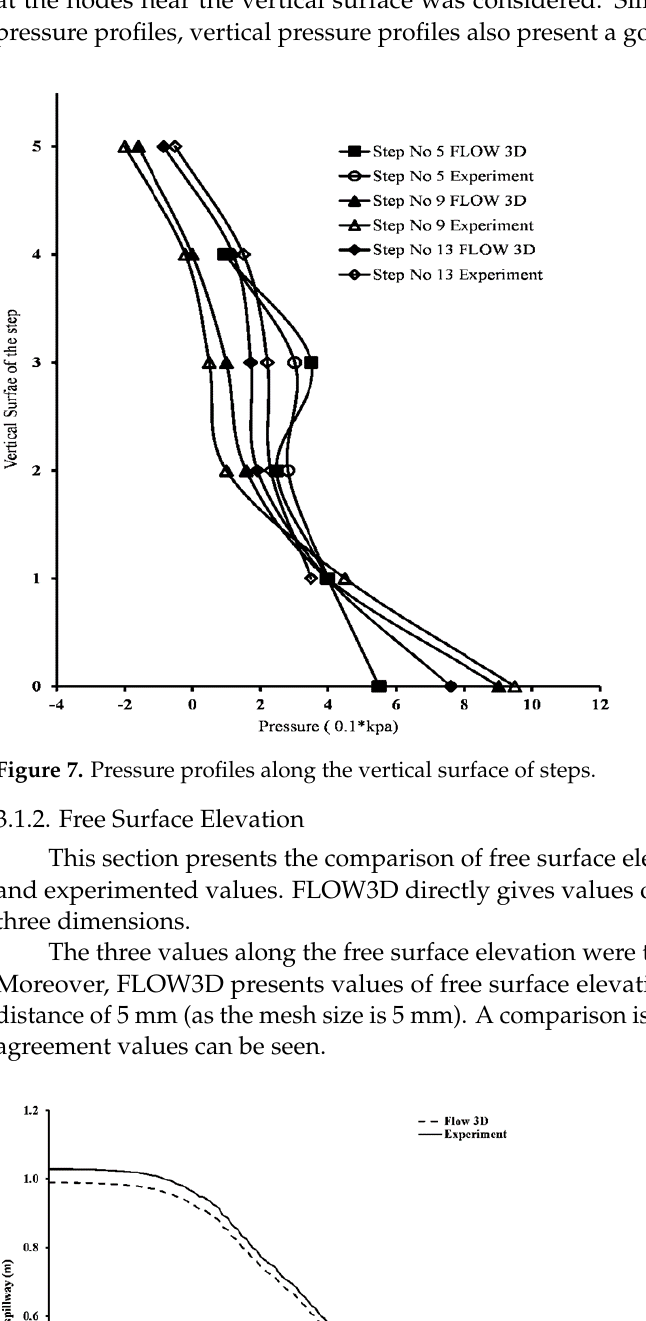
Figure 6. Pressure profiles comparison along the horizontal surface.